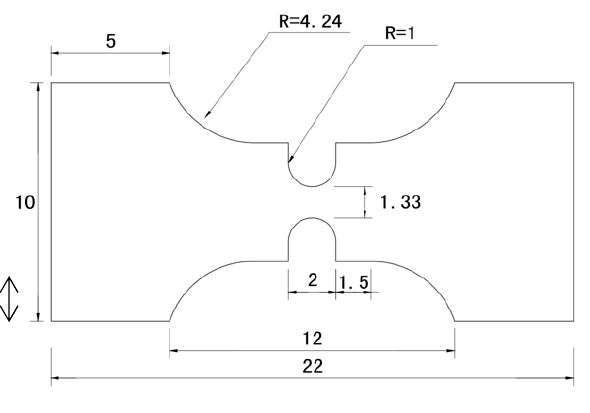
Figure 2. Dimensions of the tested specimen.